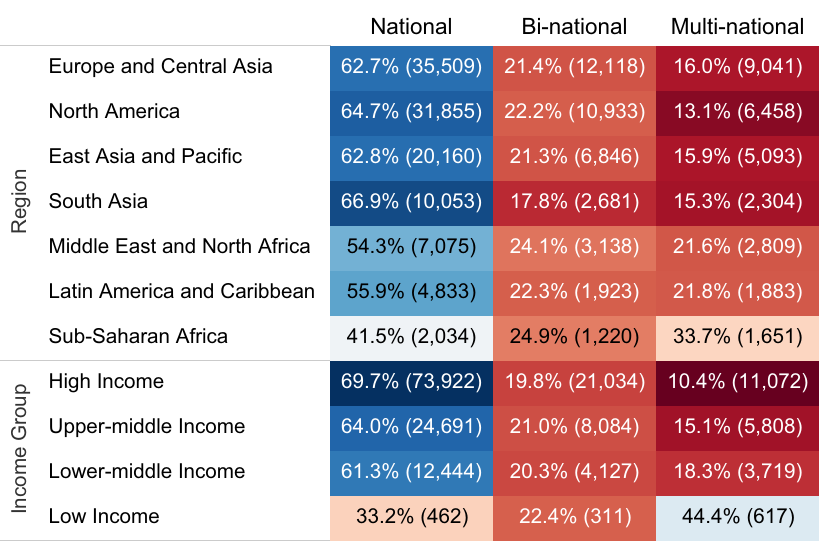
Fig 4. Distribution of the national, bi-national, and multi-national collaboration in World Bank regions and income groups.